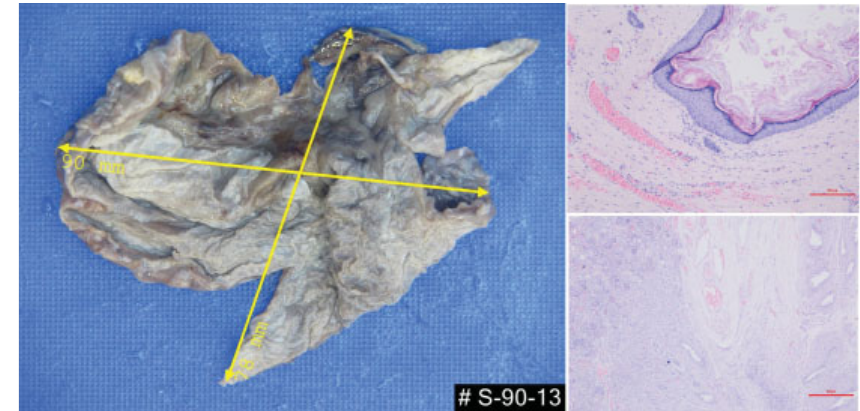
European Journal of Pediatric Surgery Reports Vol. 2 No.